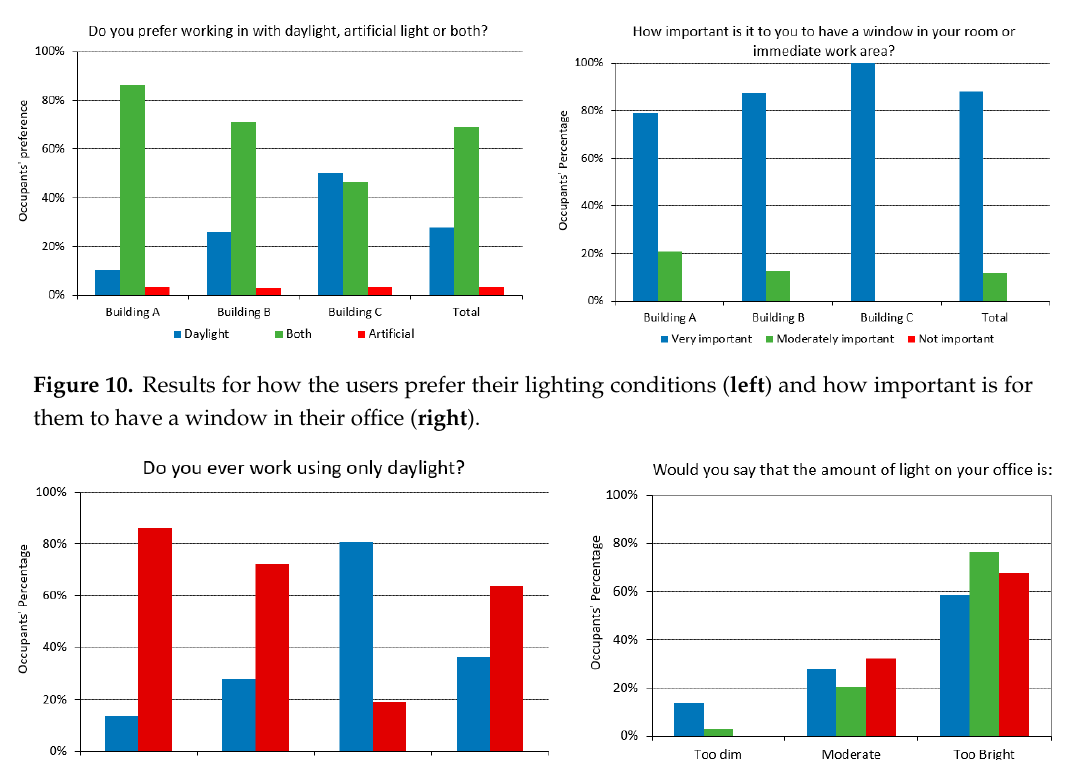
Figure 11. Results of how often the occupants work using only daylight ( left ) and the amount of total light on their space ( right ).